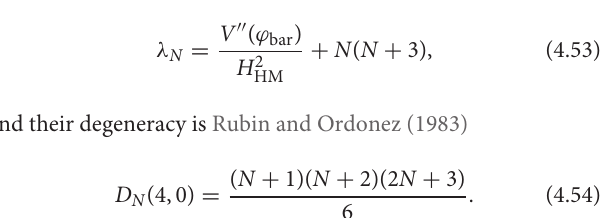
1.193 10 8 GeV, H cross 1.931 10 8 GeV are also plotted, along with B 0 , the bounce action obtained at H = × = ×